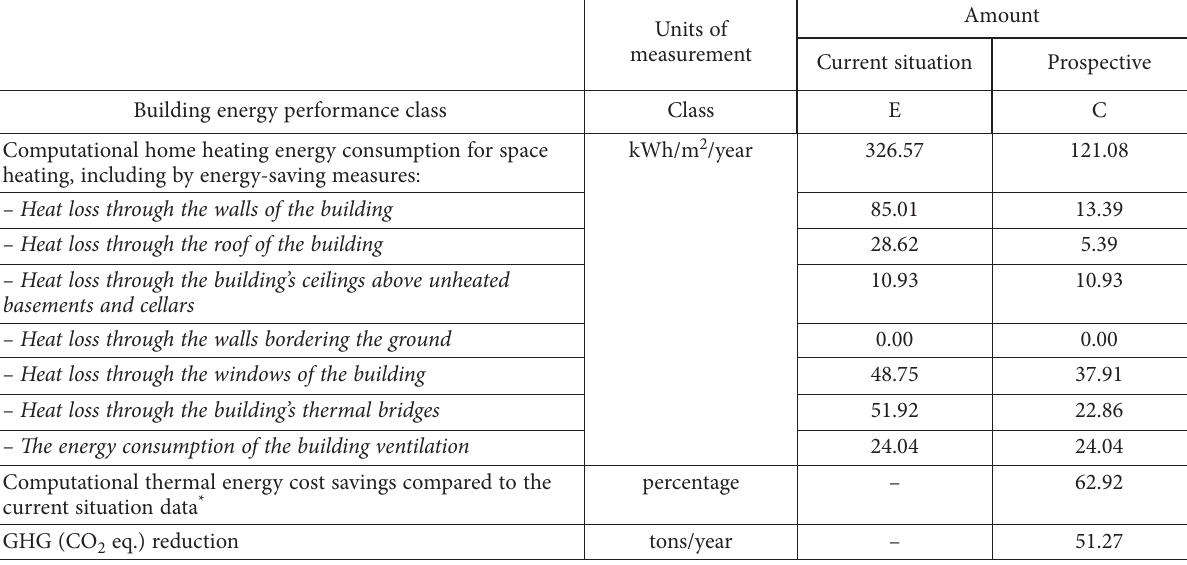
Table 8. Predicted energy savings after refurbishment for Alternative 5